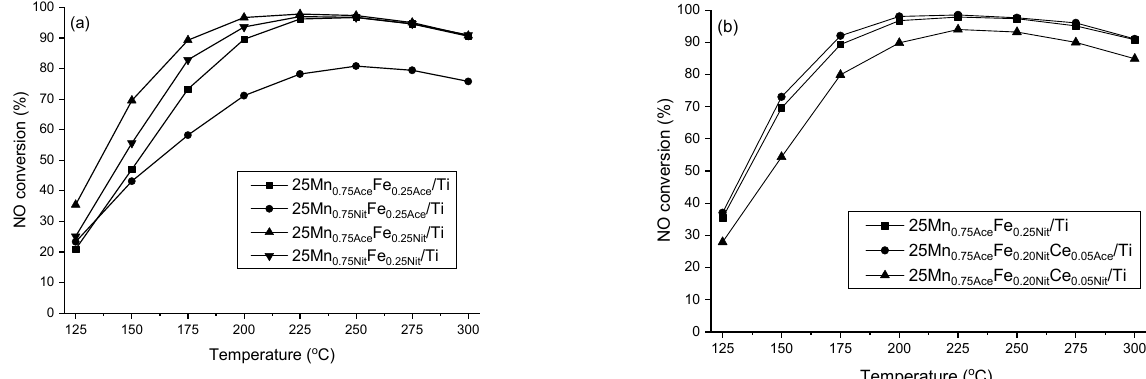
Figure 2. NO conversion profiles of catalysts prepared by different precursors: ( a ) 25Mn 0.75 Fe 0.25 /Ti; ( b ) 25Mn 0.75 Fe 0.20 Ce 0.05 /Ti.